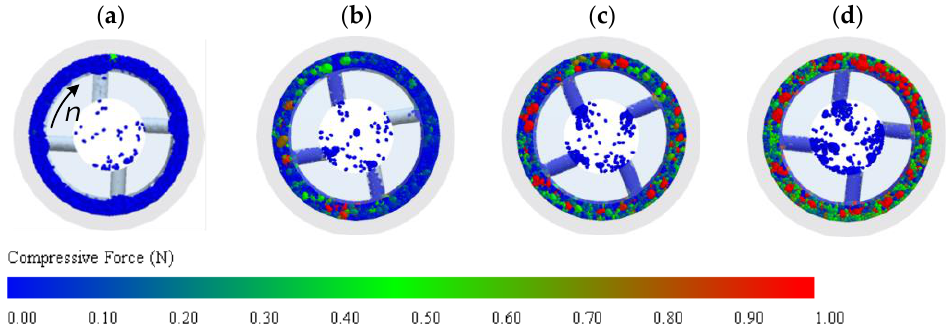
Figure 9. Compressive forces on drilling cuttings at: ( a ) 0.2 s; ( b ) 0.4 s; ( c ) 0.6 s, and ( d ) 0.8 s.